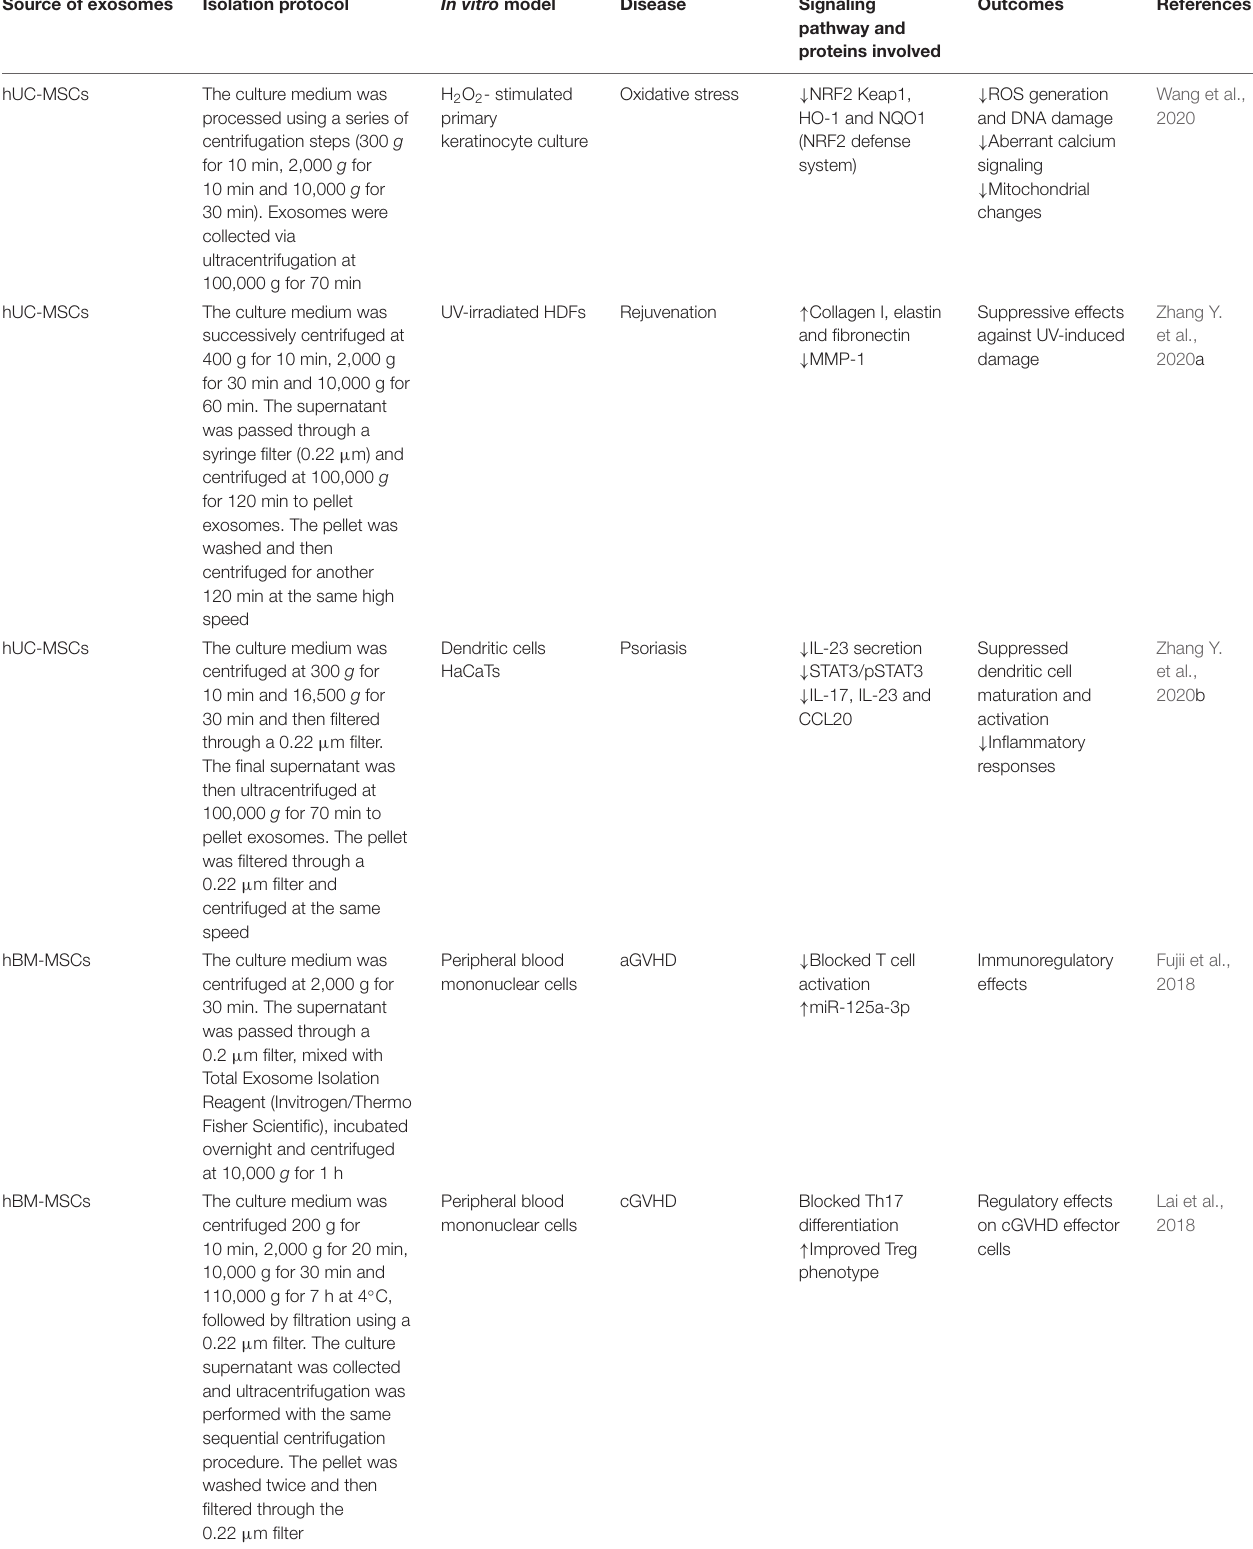
TABLE 1 | In vitro studies of MSC exosomes in other skin